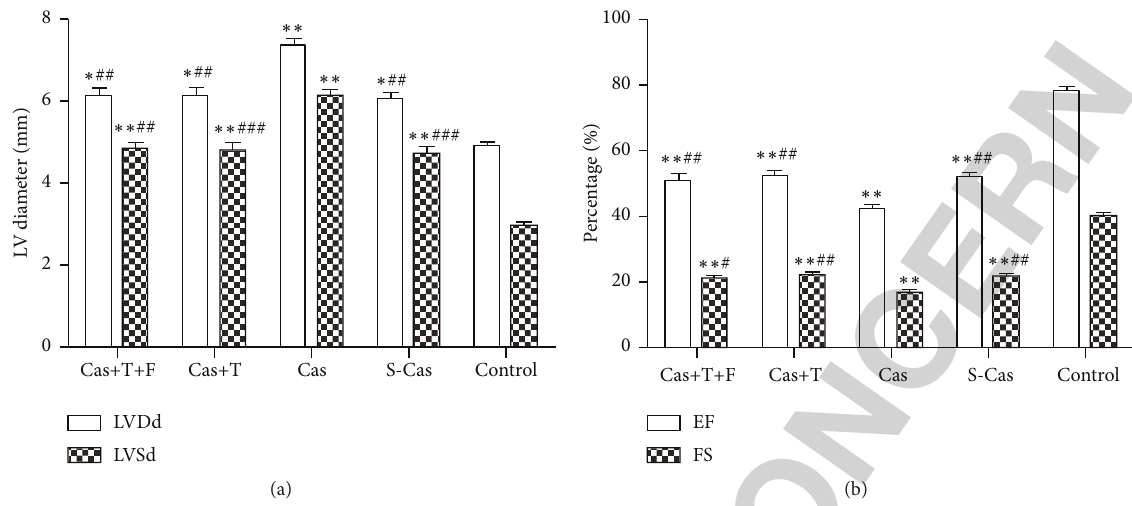
Figure 7: Echocardiography results 14 days after ligation. (a) Left ventricular end-diastolic diameter (LVDd) and left ventricular end-systolic diameter (LVSd) measurements for all groups. (b) Ejection fraction (EF) and fractional shortening (FS) results for all groups. Values are means ± SD; 𝑛 = 4 . S-Cas: sham-castration; Cas: castration; T: testosterone; F: flutamide. ∗ 𝑃 < 0.01 and ∗∗ 𝑃 < 0.001 versus control group; # 𝑃 < 0.05 , ## 𝑃 < 0.01 , and ### 𝑃 < 0.001 versus